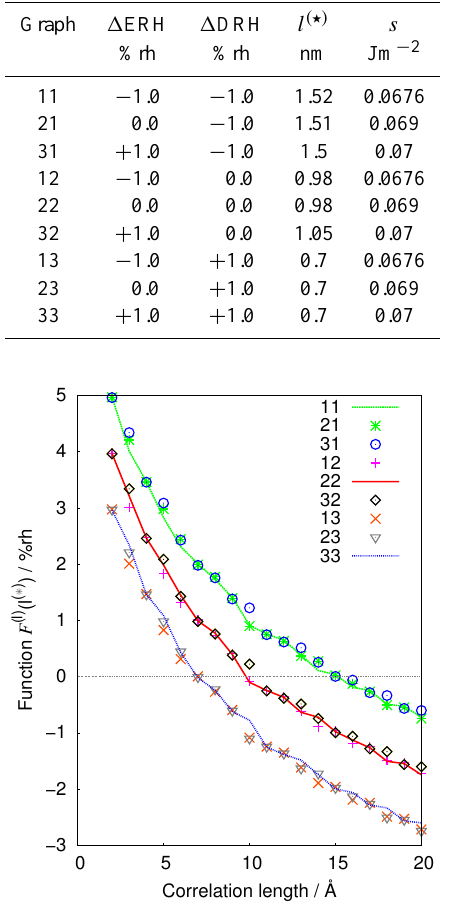
Figure 3. Function F (l) dependent on the correlation length l ((cid:63)) according to Eq. (8) for six possible combinations of (cid:49) ERH and (cid:49) DRH values according to Table 2. The sought-after value l ((cid:63)) is the abscissa value corresponding to the ordinate value F (l) (σ (αγ) ∞ ) = 0, indicated by the solid horizontal line.